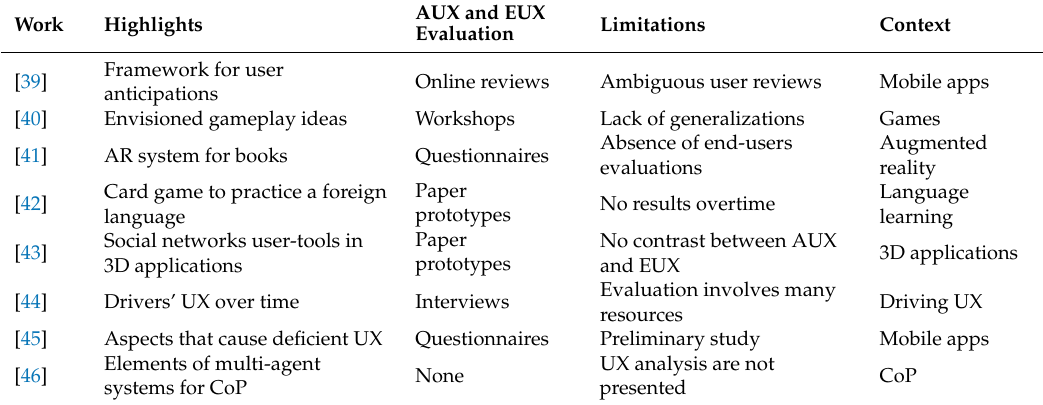
Table 1. Synthesis of related